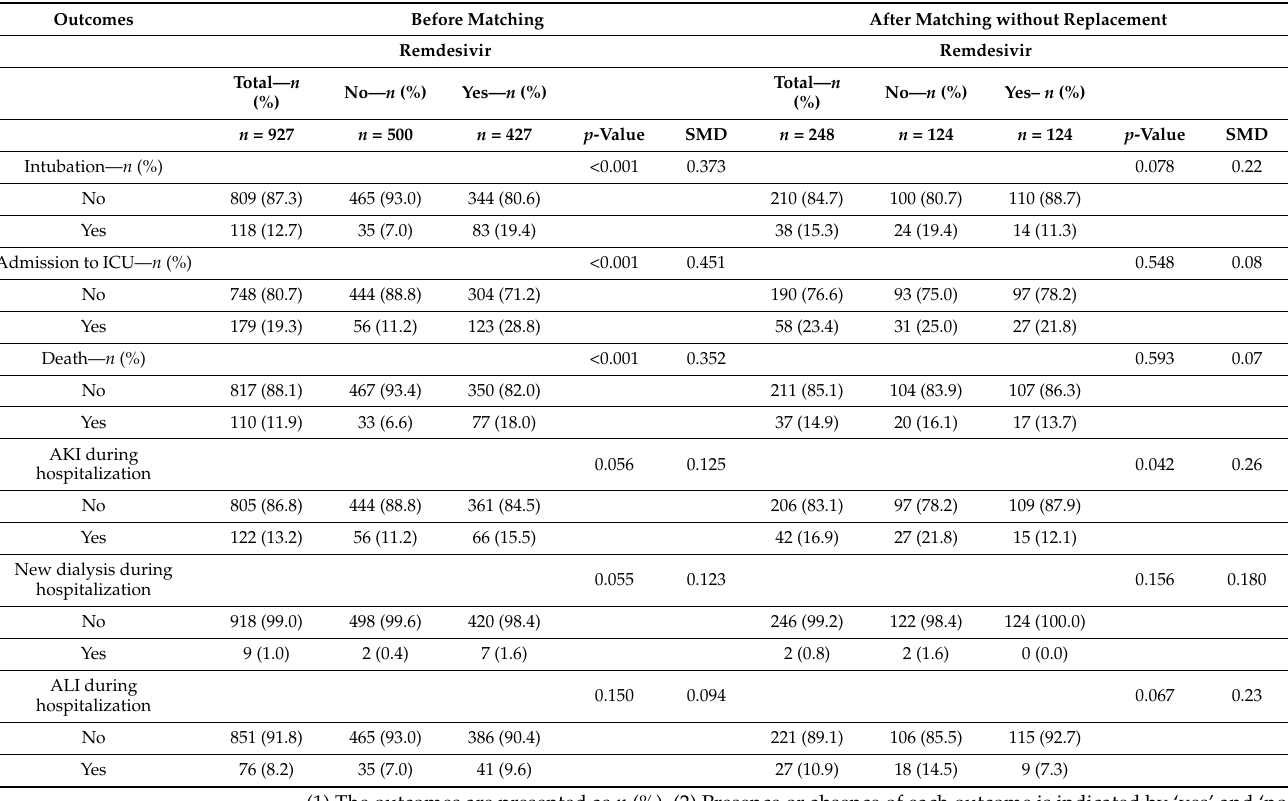
Table 3. In-hospital outcomes.